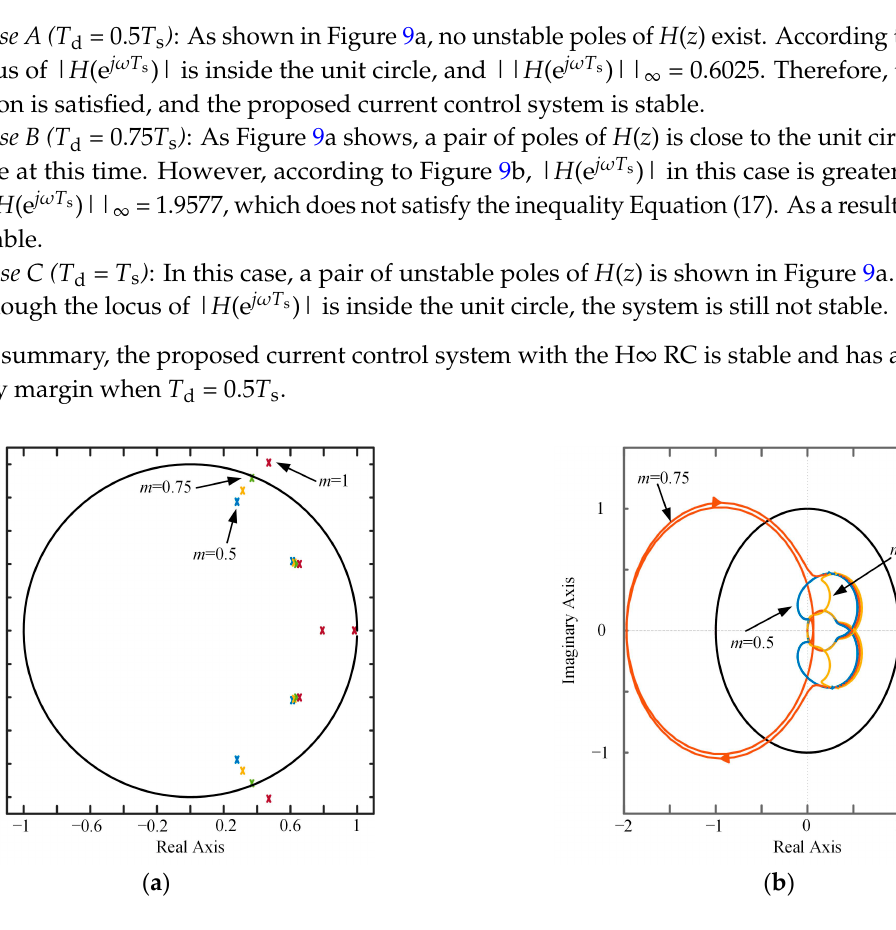
Figure 9. Stability analysis for the system with variable T d ( T d = mT s , 0 ≤ m ≤ 1). ( a ) Pole map of H ( z ); and ( b ) locus of the vector | H ( e j ω T s )|.